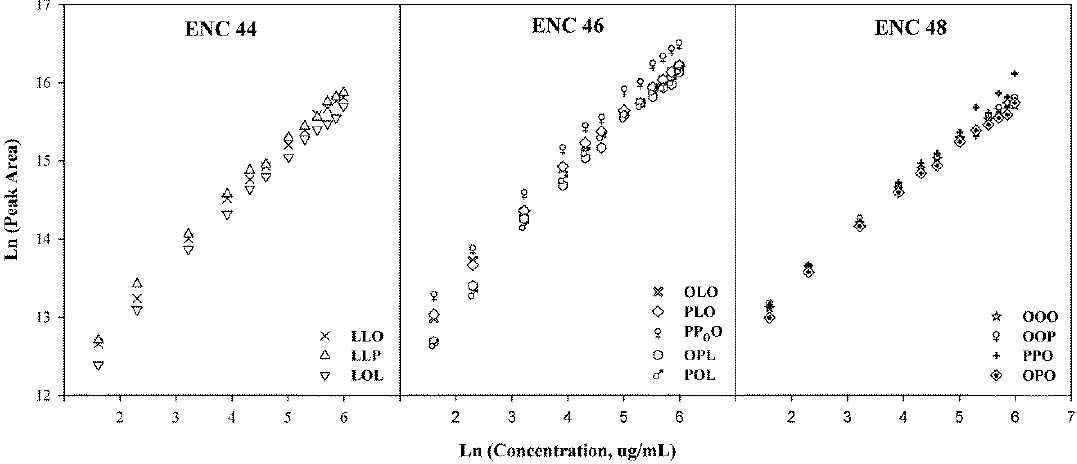
Figure 6. Calibration curves (grouped by ECN) for 12 commercially available reference standards .